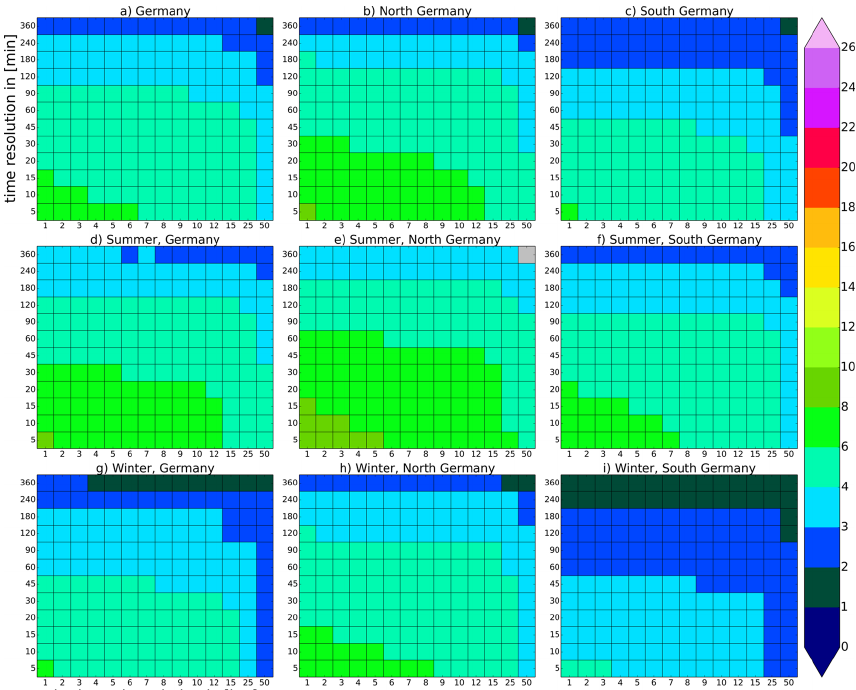
Figure 4. Stratiform extremes as a function of resolution; otherwise similar to Fig.